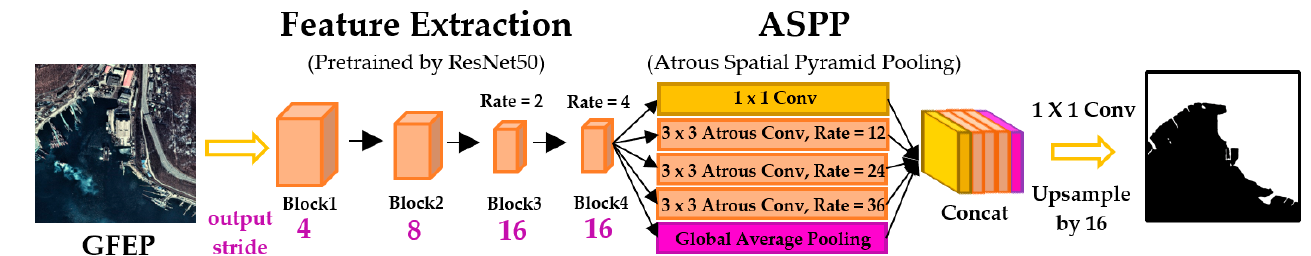
Figure 5. Architecture of semantic segmentation model for classifying land and sea regions.